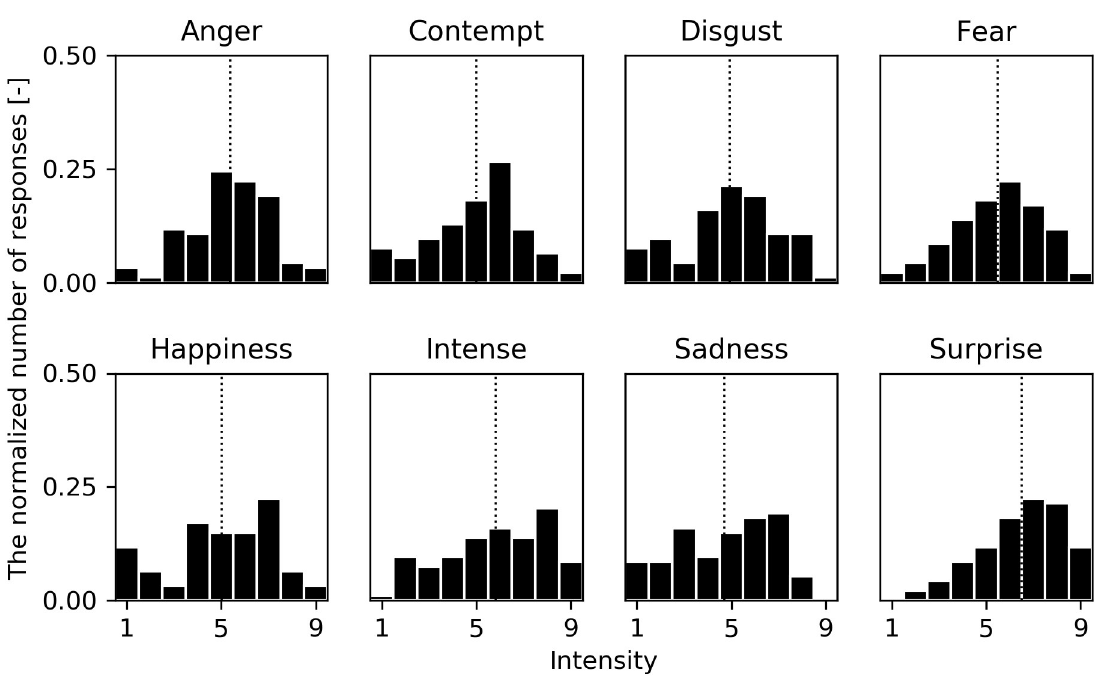
Fig 6. Distributions of the assessed facial intensity in Experiment 1. The horizontal axis shows the assessed facial intensity (1 to 9) and the vertical axis shows the normalized number of responses. The dotted line shows the mean facial intensity.